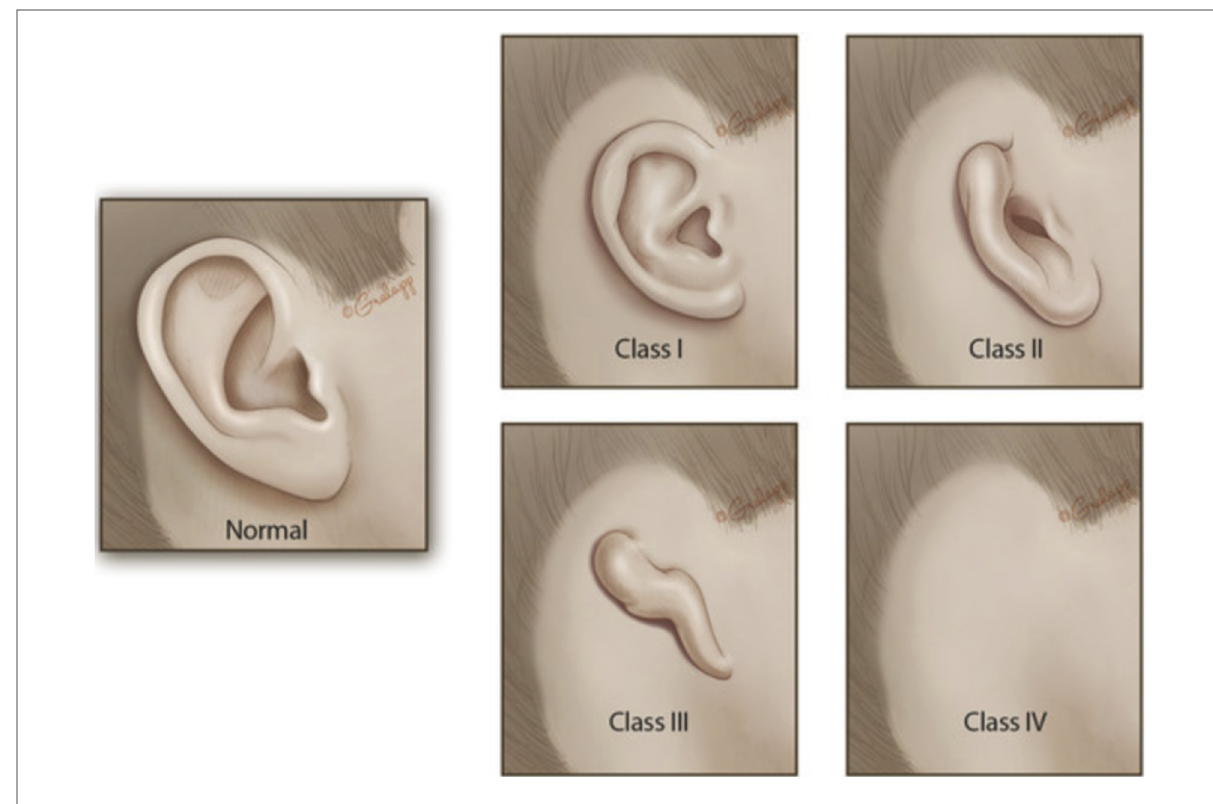
FIGURE 1 Classi fi cation of Microtia